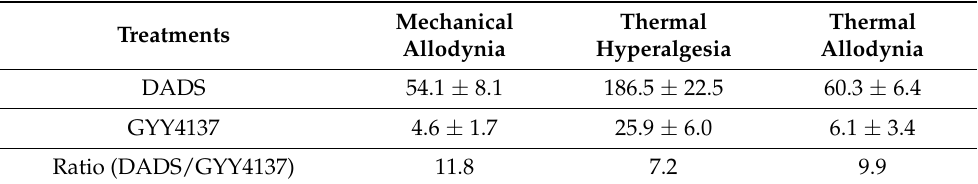
Table 1. Comparison of the potencies (ED 50 ) of DADS and GYY4137 in the inhibition of the mechani- cal allodynia, thermal hyperalgesia, and thermal allodynia induced by sciatic nerve injury. Data are expressed as ED 50 values ( µ mol/Kg) ± SEM ( n = 6 animals per dose). For each test, the ratio of the ED 50 values between drugs is also indicated.